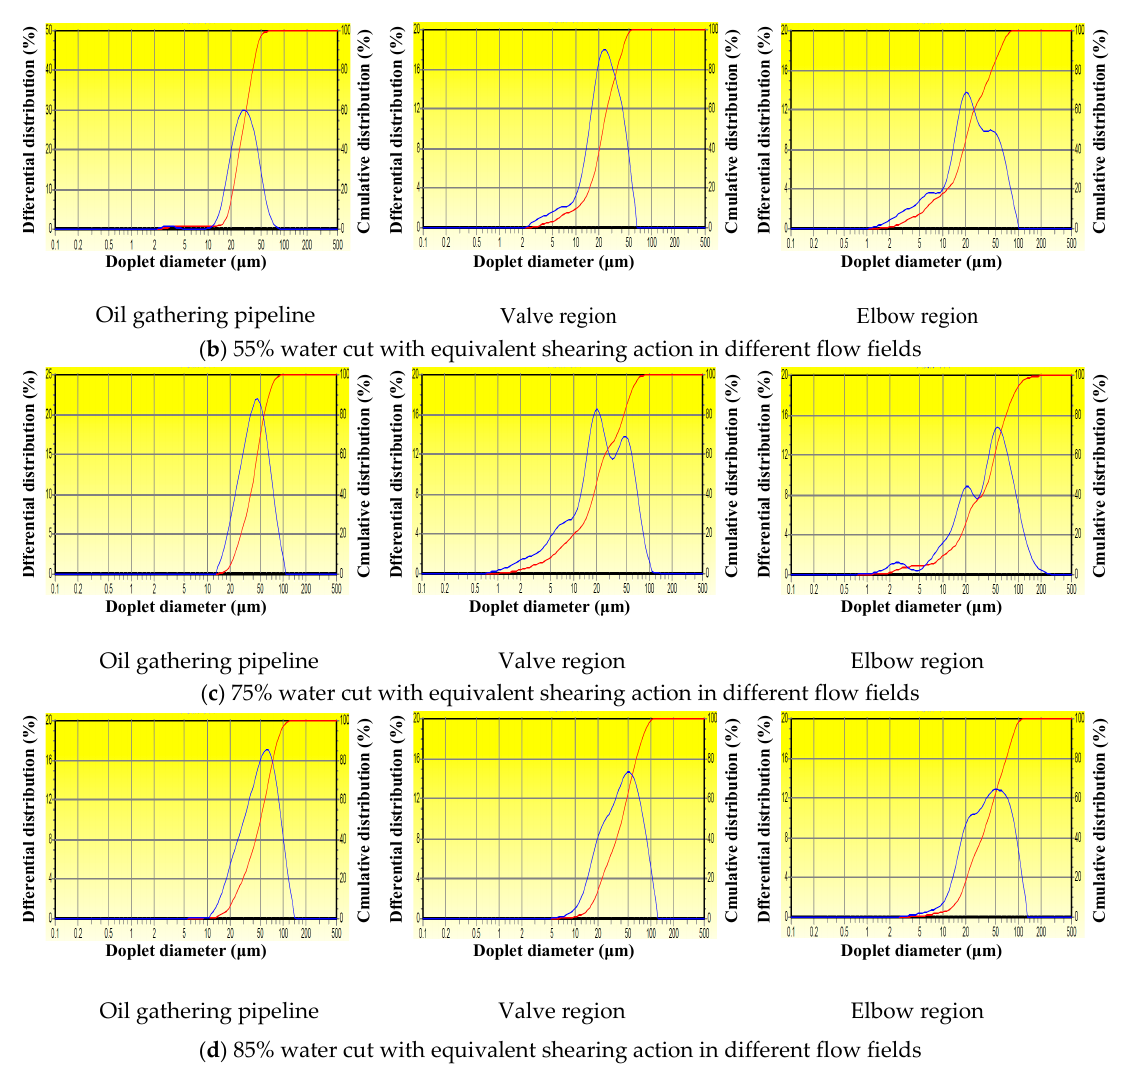
Figure 9. Droplet-size distribution of the waxy crude oil emulsions.